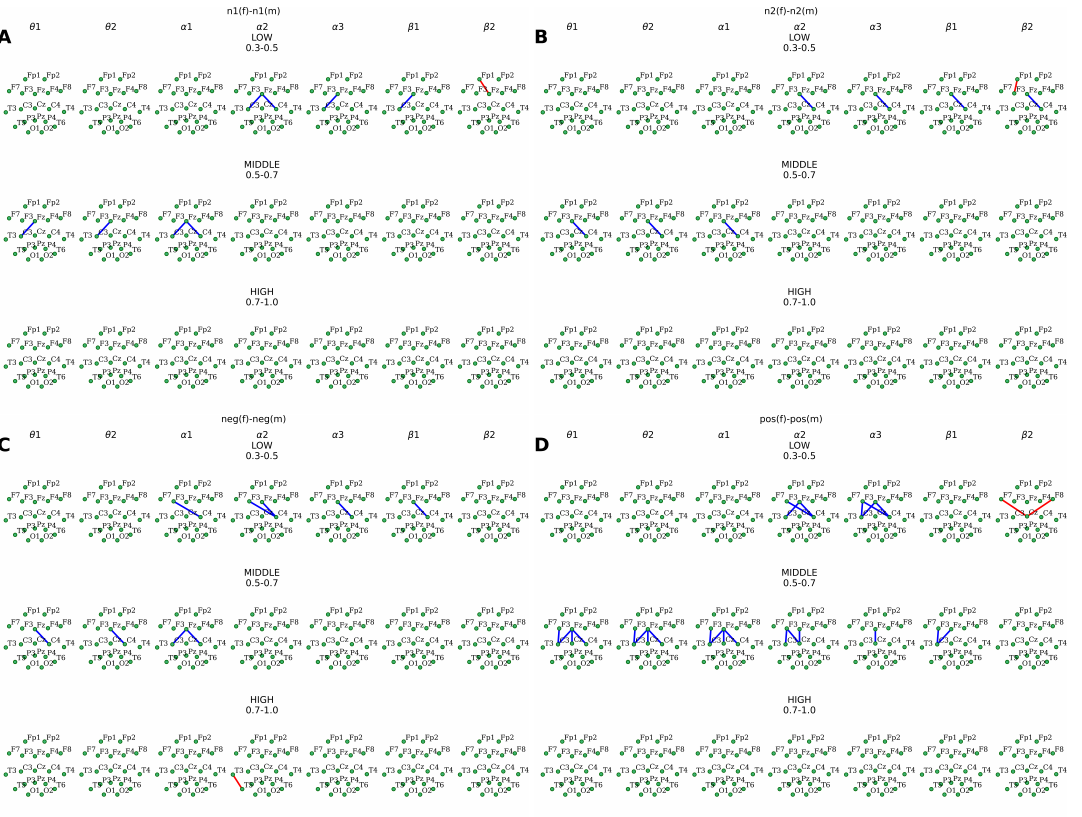
Figure 5. Topographical distribution of statistically significant coherent connection differences. ( A ) n1 (f)/ n1(m). ( B ) n2(f)/n2(m). ( C ) neg (f)/ neg (m). ( D ) pos (f)/ pos (m). Red line—the difference between medians is larger than zero; blue line—the difference is less than zero; no line—there is no significant